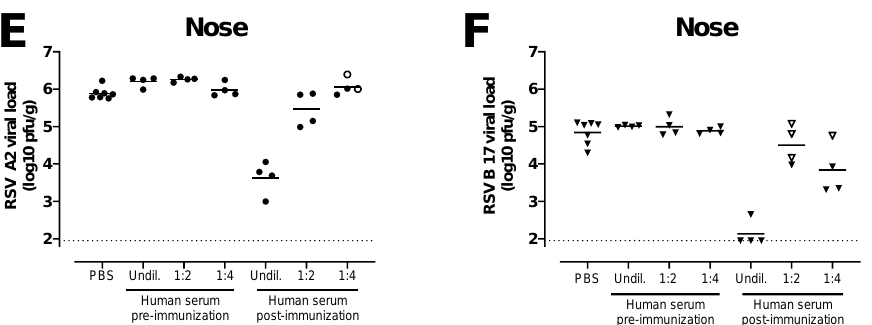
Figure 5. Serum of human subjects that received vaccination with the combination of Ad26.RSV.preF and RSV preF protein can provide protection against RSV A and RSV B strains in the cotton rat model. Cotton rats received different amounts (2 mL of undiluted (undil.), 1:2 or 1:4 diluted serum in PBS) of a human serum pool generated by pooling serum isolated pre-vaccination or at 14 days post-vaccination with a mixture of 10 11 vp Ad26.RSV.preF and 150 μg preF protein (n = 39) by intraperitoneal injection (n = 4 per group) or with PBS (n = 7). The next day, pre-challenge serum samples of the recipient animals were isolated and assayed for VNT against RSV A 18-001989 ( A ) or for RSV B 17-058221 ( B ). Animals were challenged with RSV A2 ( C , E ) or RSV B 17-058221 ( D , F ). RSV viral load was determined five days after the challenge using plaque assay on homogenates of the lung ( C , D ) or nose tissue ( E , F ) and expressed as pfu per gram of tissue. Samples of animals that were (to be) challenged with RSV A2 are indicated with dots, whereas samples of animals that were (to be) challenged with RSV B 17-058221 are indicated with triangles. Animals in which serum transfer was not successful, based on low VNT pre-challenge, are indicated with open symbols. LODs for MN VNA were determined as the mean plus 3× standard deviations of the PBS control group. LODs are indicated with dotted lines.